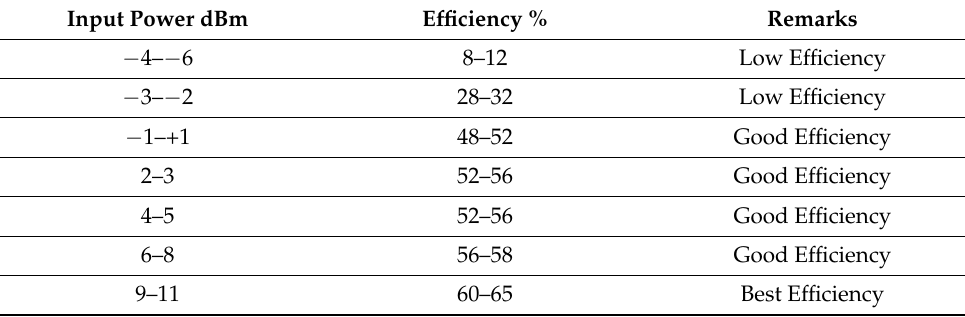
Table 12. Measured Harvester efficiency as function of input collected